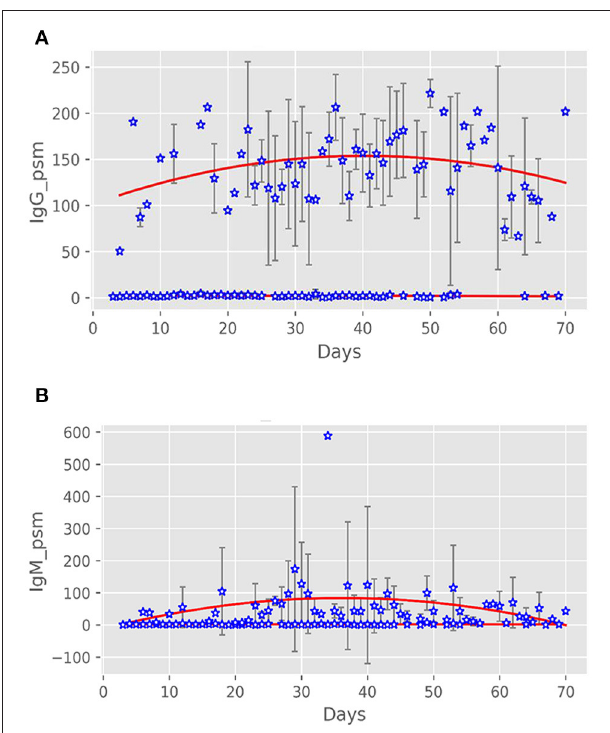
FIGURE 1 | Antibody expression after onset of patients with COVID-19. (A) IgG expression after onset in the two groups of patients. (B) IgM expression after onset in the two groups of patients.